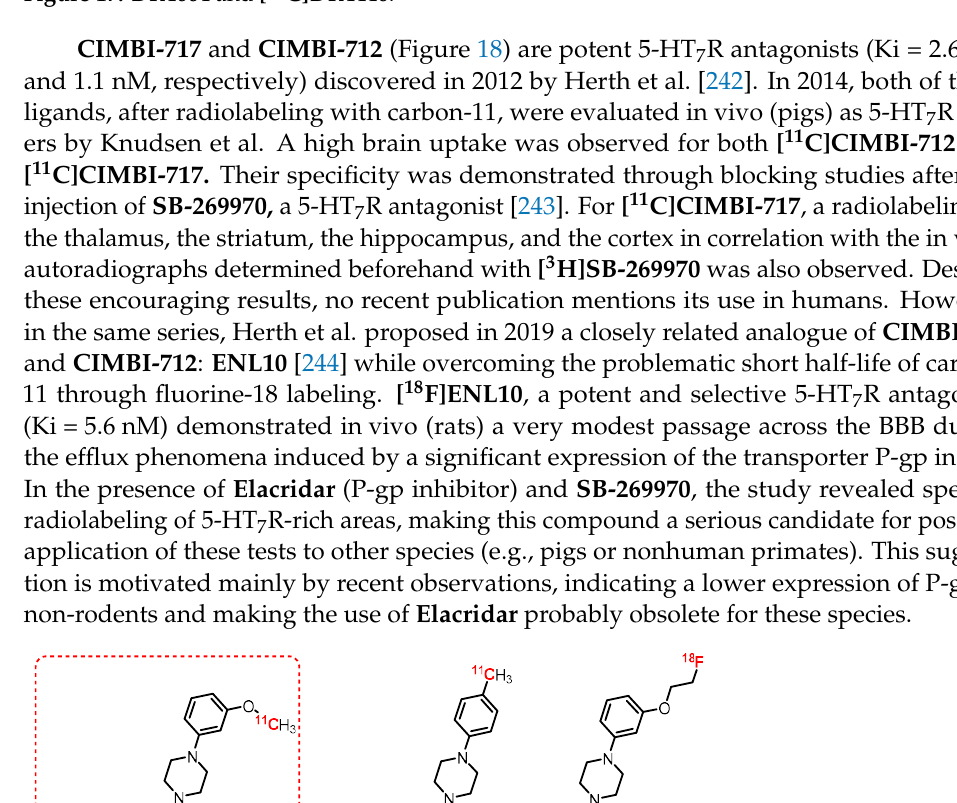
Figure 17. DR4004 and [ 11 C]DR4446 .